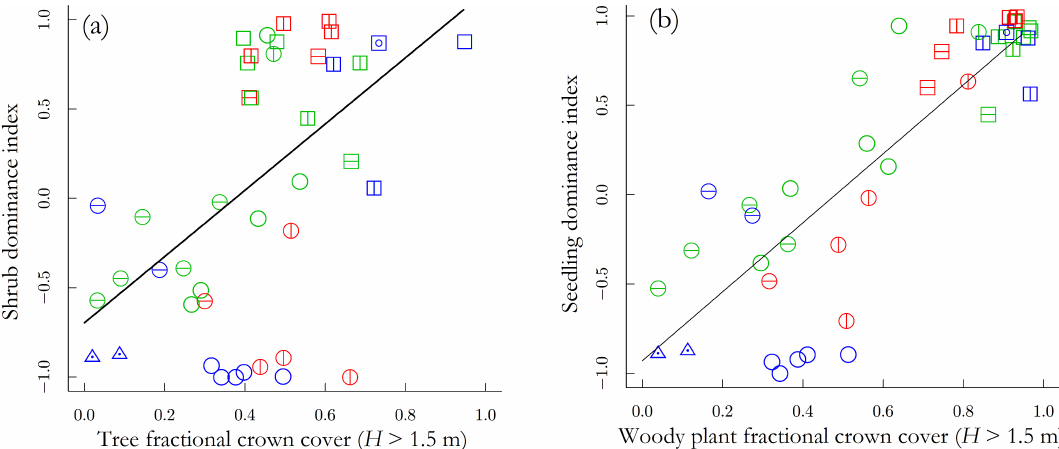
Figure 5. Relationships between upper stratum woody plant canopy dominance and measures of shrub/seedling competition in the lower layers. (a) Relationship between a shrub-dominance index ( χ 1 : Eq. 3a) and the total fractional cover of all tree species with a height ( H) > 1 . 5m; (b) a measure of (tree + shrub) seedling dominance ( χ 2 : Eq. 3b) and the total woody crown cover ( H > 1 . 5m). Symbols as in Fig. 1. Lines represent of a linear robust (high breakpoint) regression fit to the data.